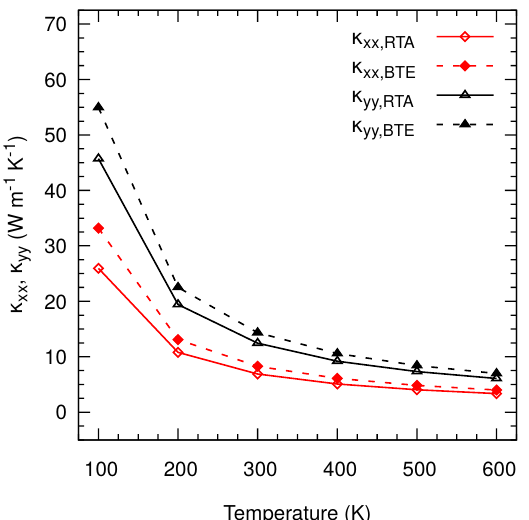
Figure 5. Evolution of the components of the thermal conductivity tensor as a function of temperature of bulk TiS 3 .